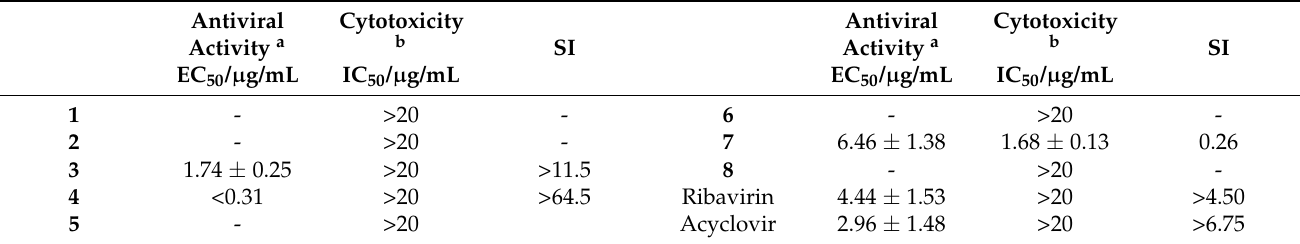
Table 3. Antiviral activity and cytotoxicity of compounds 1 – 8 .